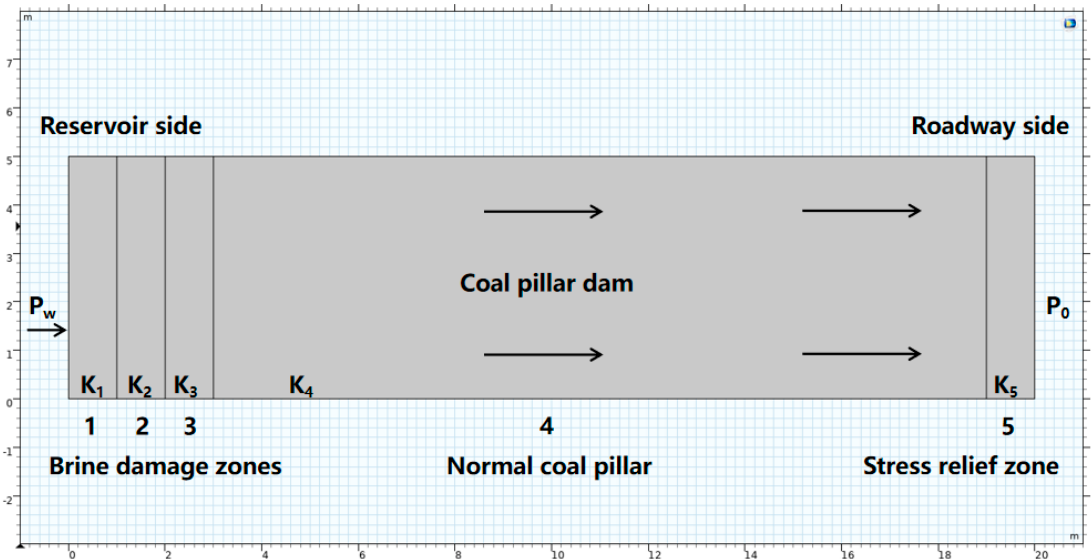
Figure 13. Schematic diagram of damage zone distribution in the coal pillar dam.